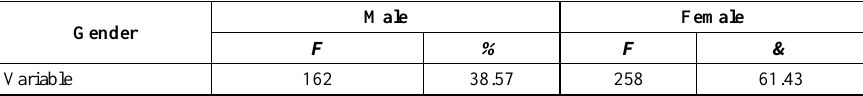
Table 1. Distribution of university students by gender